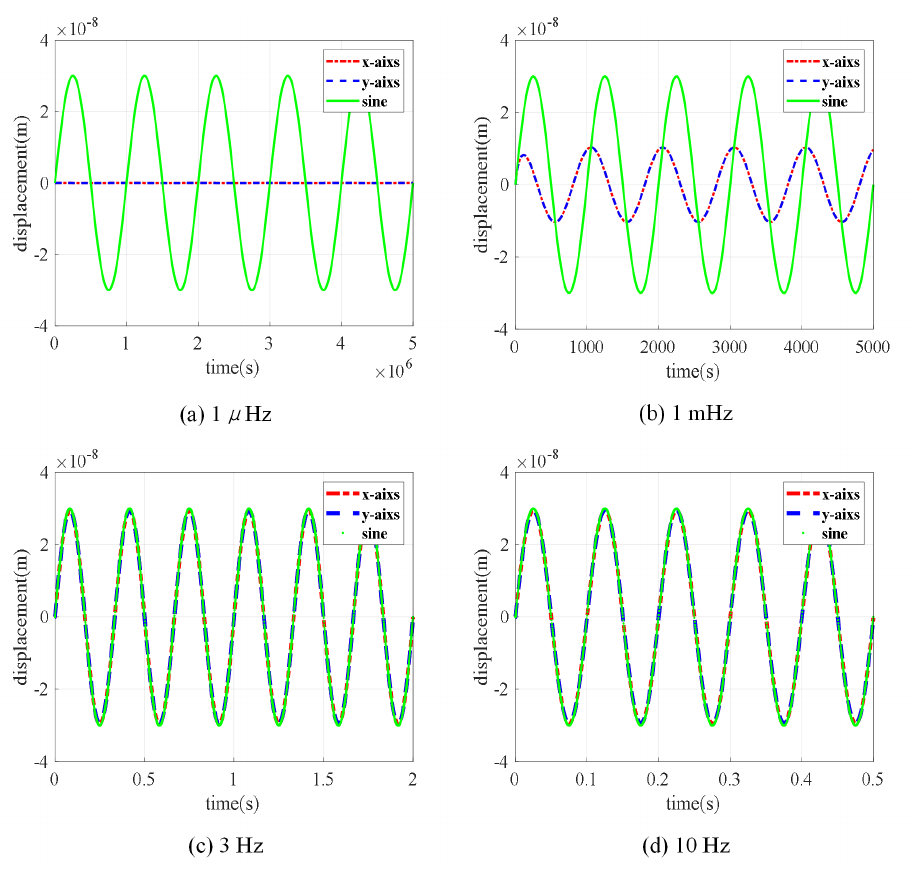
Figure 9. Tracking of sine signal for electrostatic suspension at ( a ) 1 µ Hz, ( b ) 1 mHz, ( c ) 3 Hz, ( d ) 10 Hz.